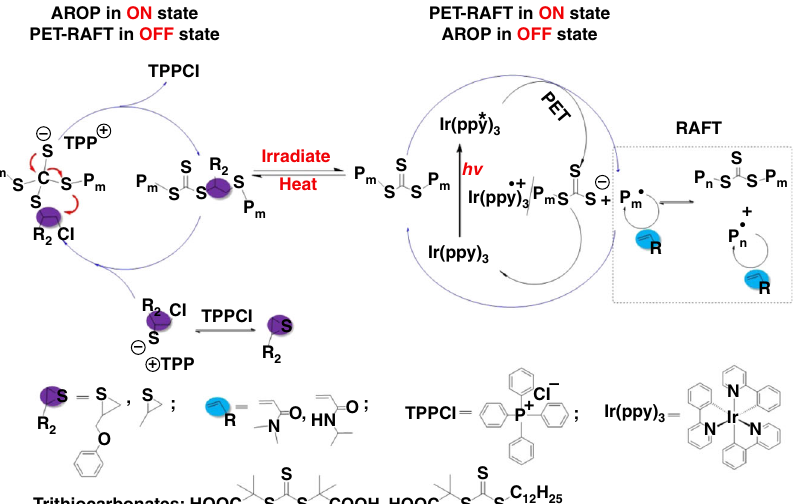
Fig. 1 Mechanism of dually switchable and controlled interconvertible polymerizations. AROP and PET-RAFT polymerization can be switched ON/OFF and interconverted in response of